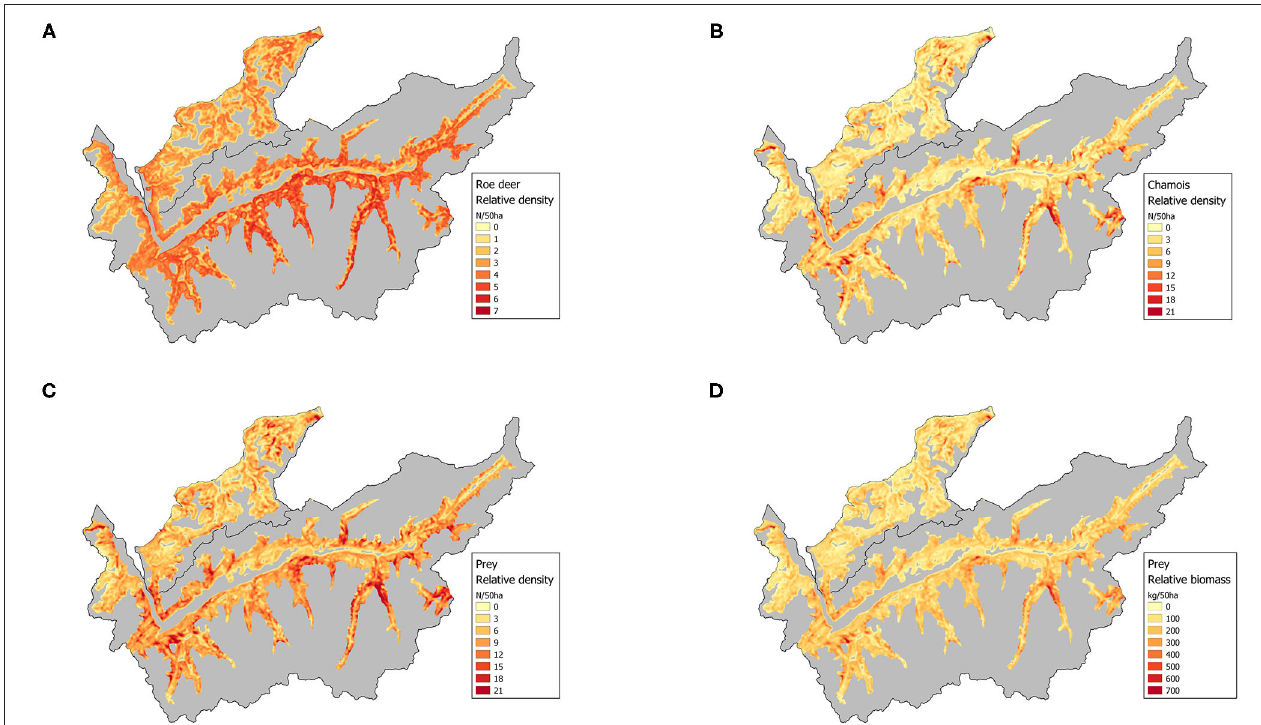
FIGURE 4 | Maps of predicted relative densities of (A) roe deer (ranging from 0.44 to 6.61 individuals per 50 ha); (B) chamois (0–37.76 per 50 ha); (C) both species grouped (0.47–42.59 per 50 ha) and (D) their biomass (8.38–896.39kg per 50 ha). Predictions were restricted to the colored